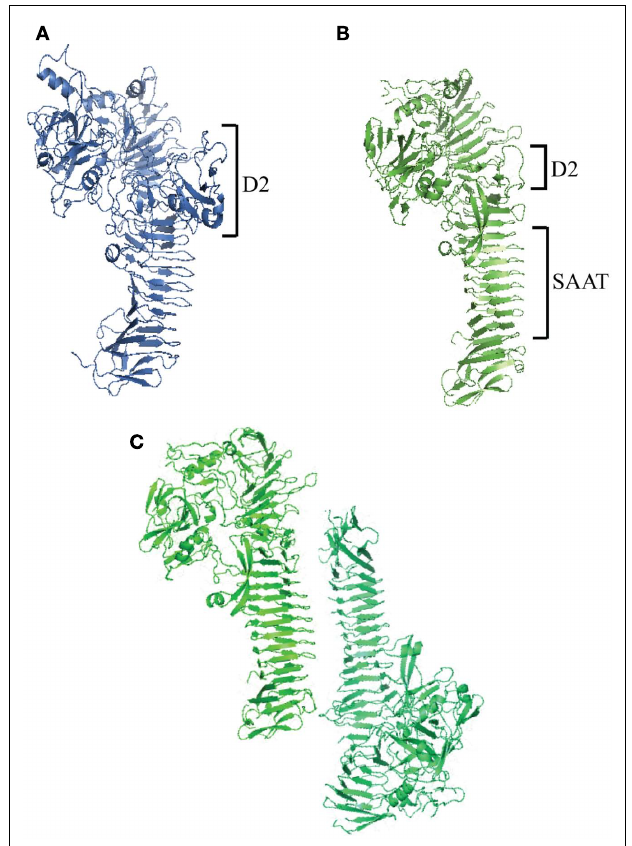
FIGURE 2 | Haemophilus influenzae autotransporter structures. (A) Crystal structure of IgA1 protease passenger domain (IgA p ) with an N-terminal globular protease domain and a larger Domain 2 (D2) compared to Hap s . (B) Crystal structure of Hap passenger domain (Hap s ) with an N-terminal globular protease domain and a C-terminal SAAT β -helical domain. (C) Hap dimer highlighting Hap–Hap interactions via the SAAT